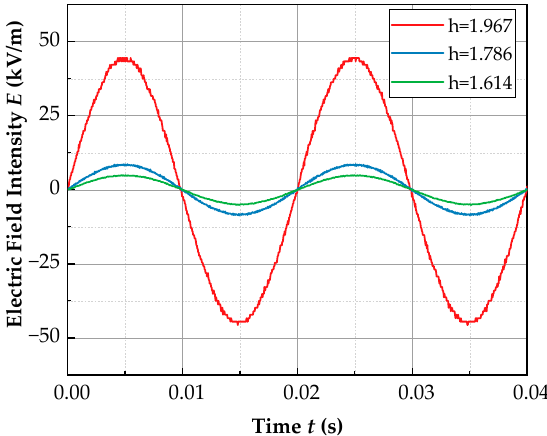
Figure 11. The electric-field waveform of three integral nodes measured by the MEMS electric-field sensor.